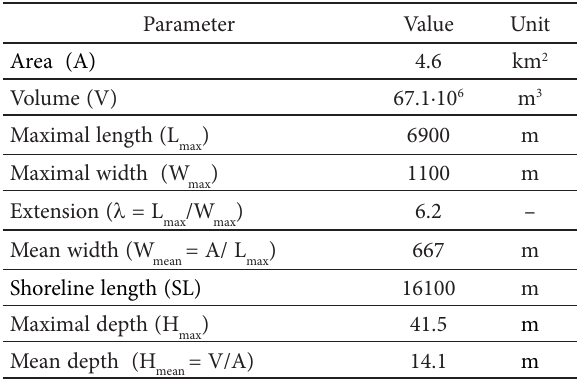
Table 1. Morphometric parameters of Lake Serwy which enable its comparison with other lakes in this